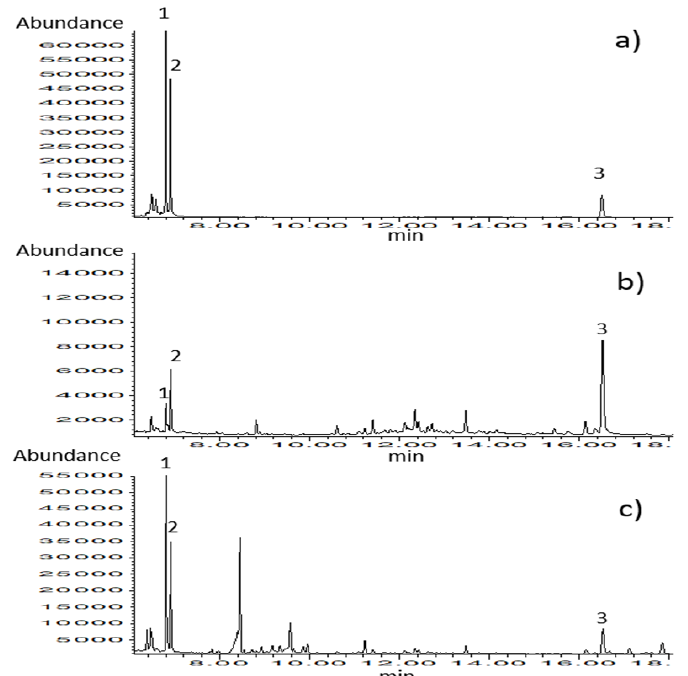
Figure 3. GC–MS chromatograms obtained in SIM mode for ( a ) calibration standard solution (c = 0.67 µg/mL), ( b ) blood plasma sample, and ( c ) milk sample. Identified compounds: 1-thymol, 2-carvacrol, and 3-ketamine (internal standard). Table 2. Results of analytical method validation.